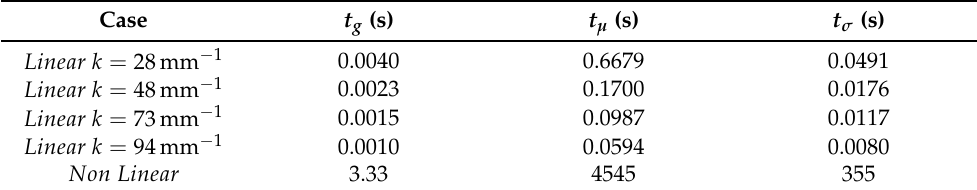
Table 5. Comparison of time scales in linear and nonlinear